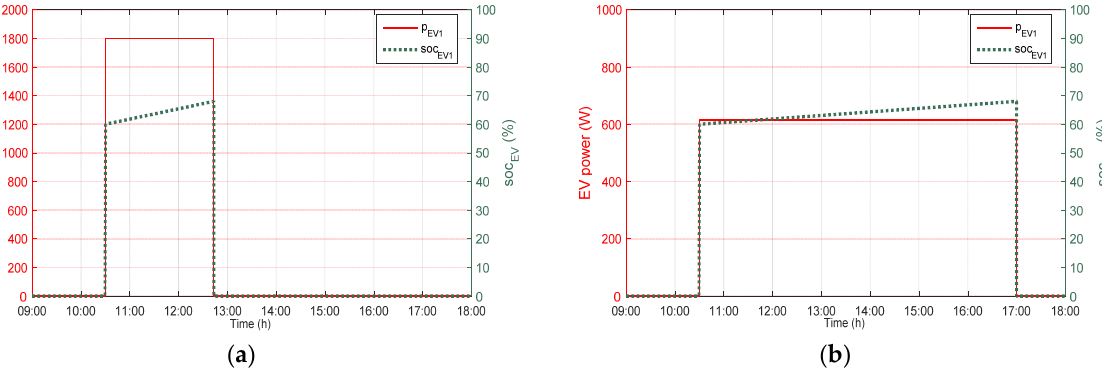
Figure 10. ( a ) EV charging power and EV SOC evolution for scenario 1a; ( b ) EV charging power and EV SOC evolution for scenario 1b.